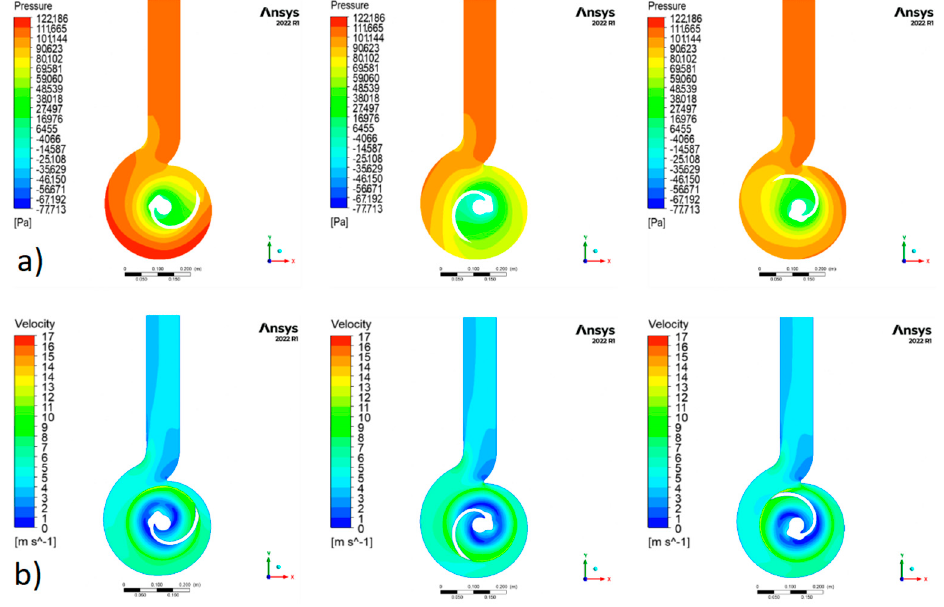
Figure 6. Pressure ( a ) and velocity ( b ) field at 28 l s –1 .